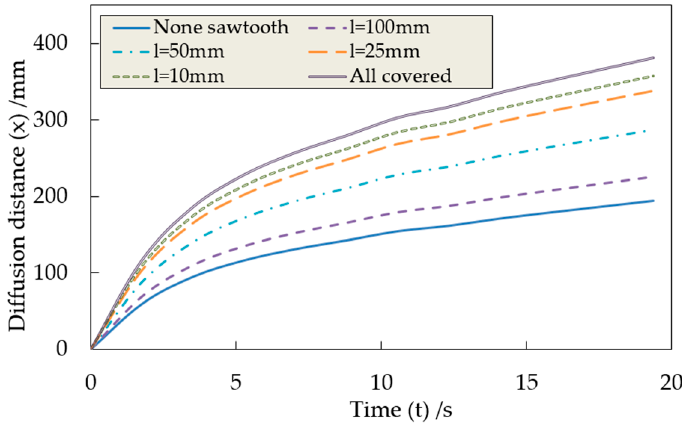
Figure 20. Comparison of grouting diffusion range under different conditions.